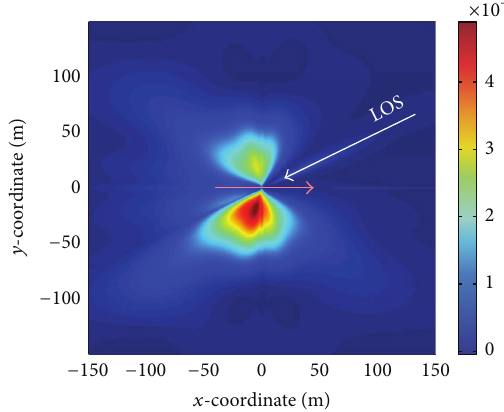
Figure 20: Discrete probability density function of the horizontal reflector position for 𝜀 = 35 ∘ under the condition of a satellite azimuth 𝜑 = 25 ∘ .